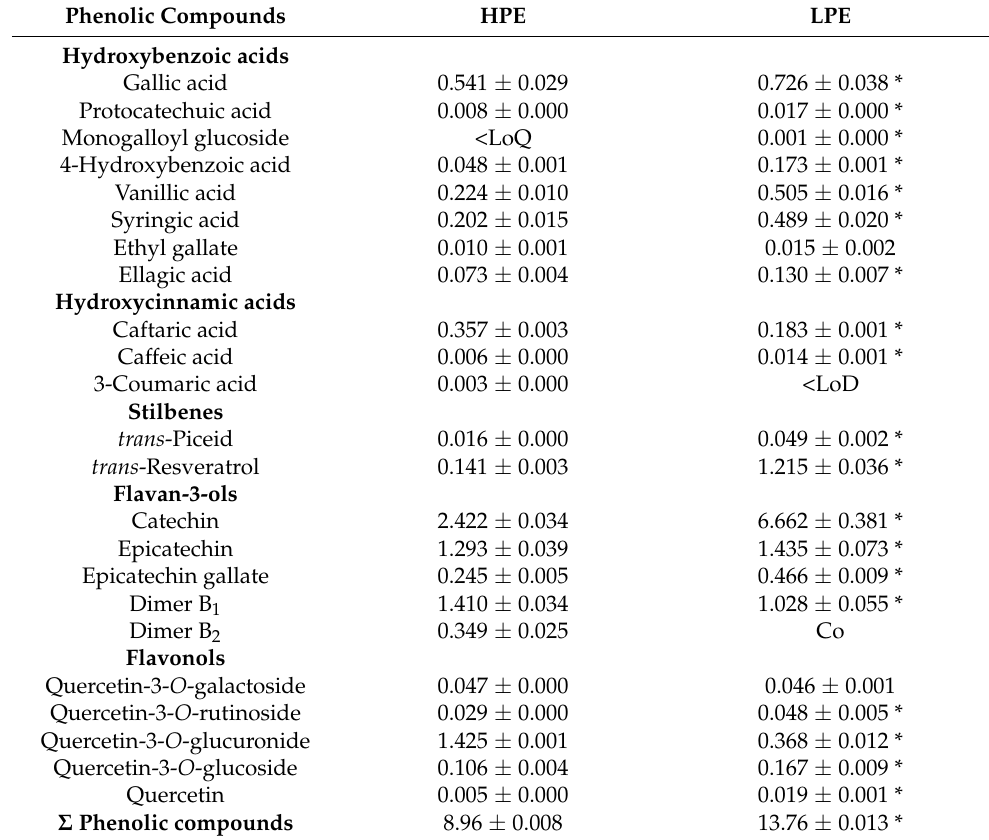
Table 2. Individual phenolic composition of PLE grape stem extracts (mg compound/g